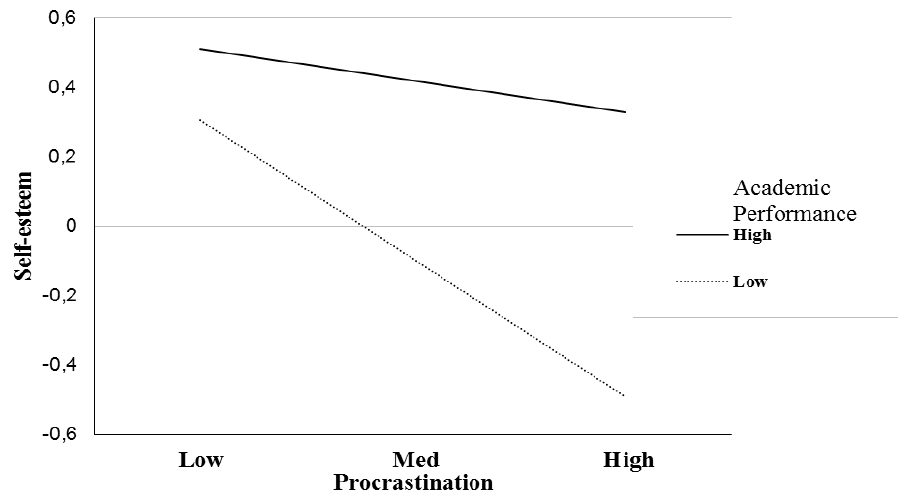
Figure 2 . Interaction effect of procrastination and academic performance on self-